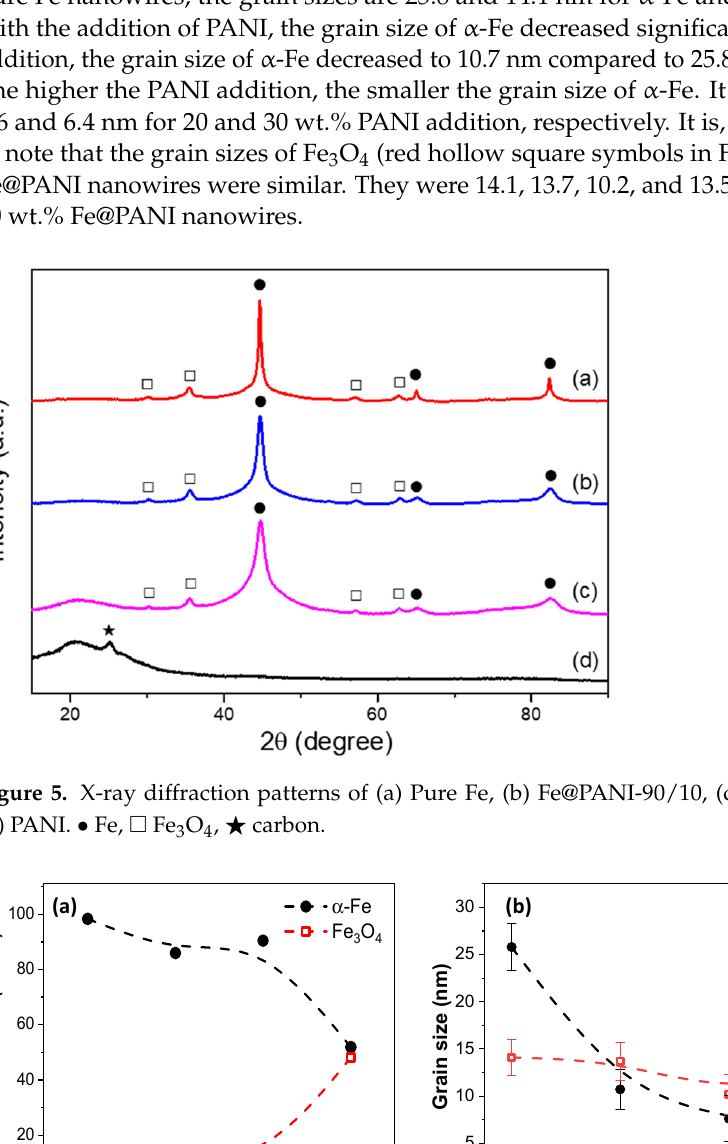
Figure 5. X-ray diffraction patterns of (a) Pure Fe, (b) Fe@PANI-90/10, (c) Fe@PANI-70-30, and (d) PANI. ● Fe, □ Fe 3 O 4 ★ , carbon.